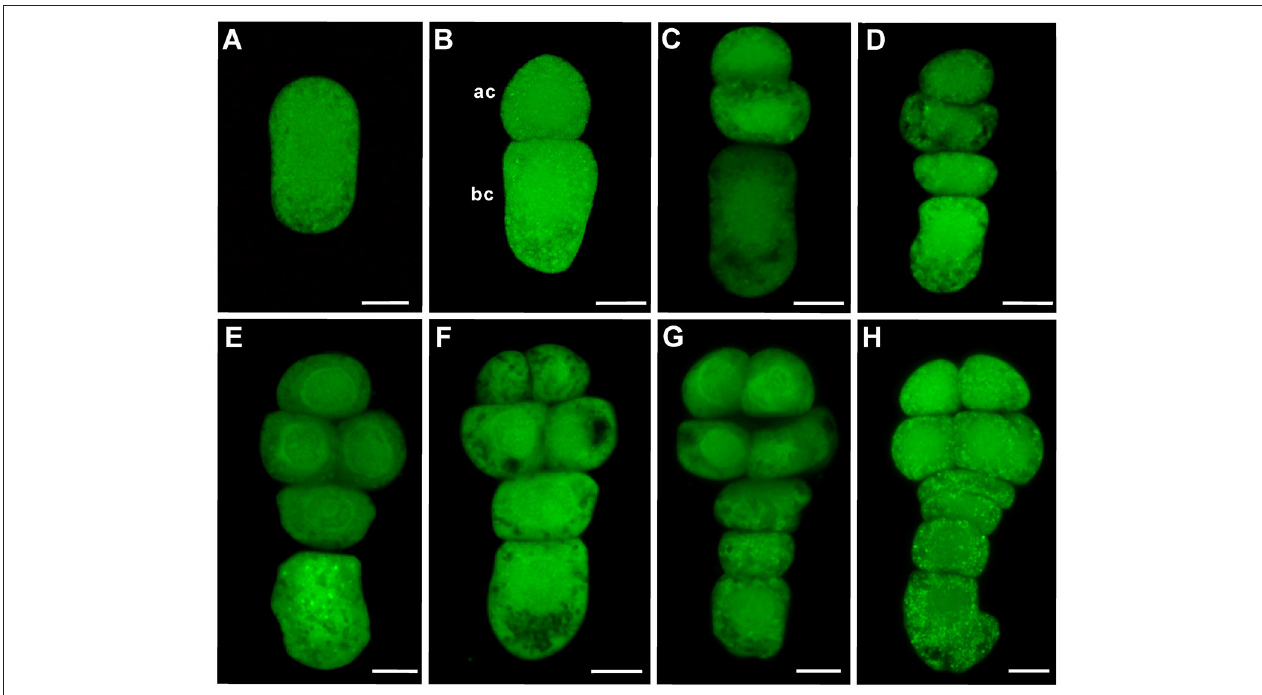
FIGURE 1 | The process of early embryogenesis in tobacco. (A) Elongated zygote, (B) Two-celled proembryo, (C) Three-celled proembryo, (D) Four-celled proembryo, (E) Five-celled proembryo, (F) Six-celled proembryo, (G) Eight-celled embryo with a three-celled suspensor, (H) Eight-celled embryo with a four-celled suspensor. Embryos were stained with FDA. Ac: apical cell; Bc: basal cell. Bar = 10 µ